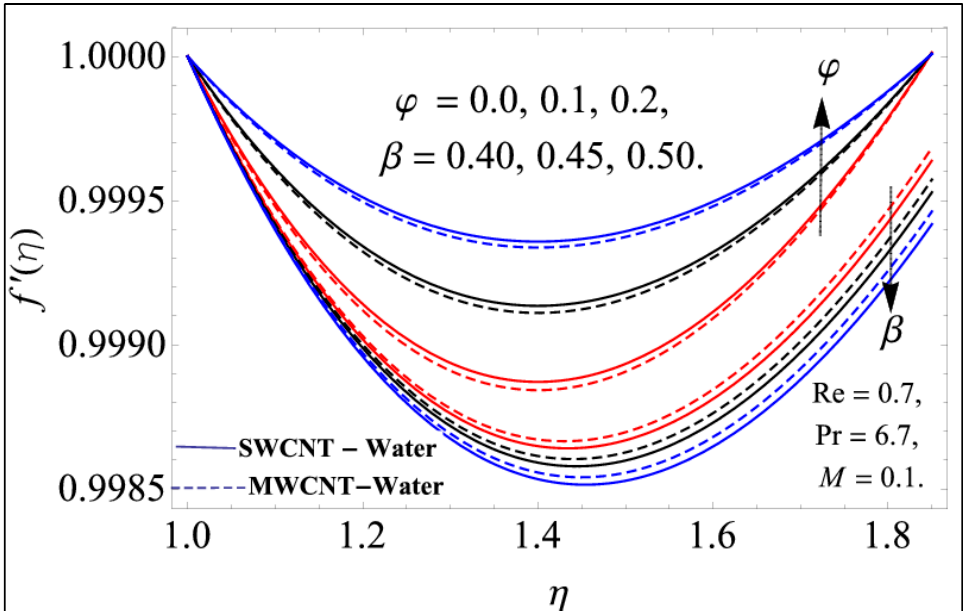
ϕ and thin film thickness parameter